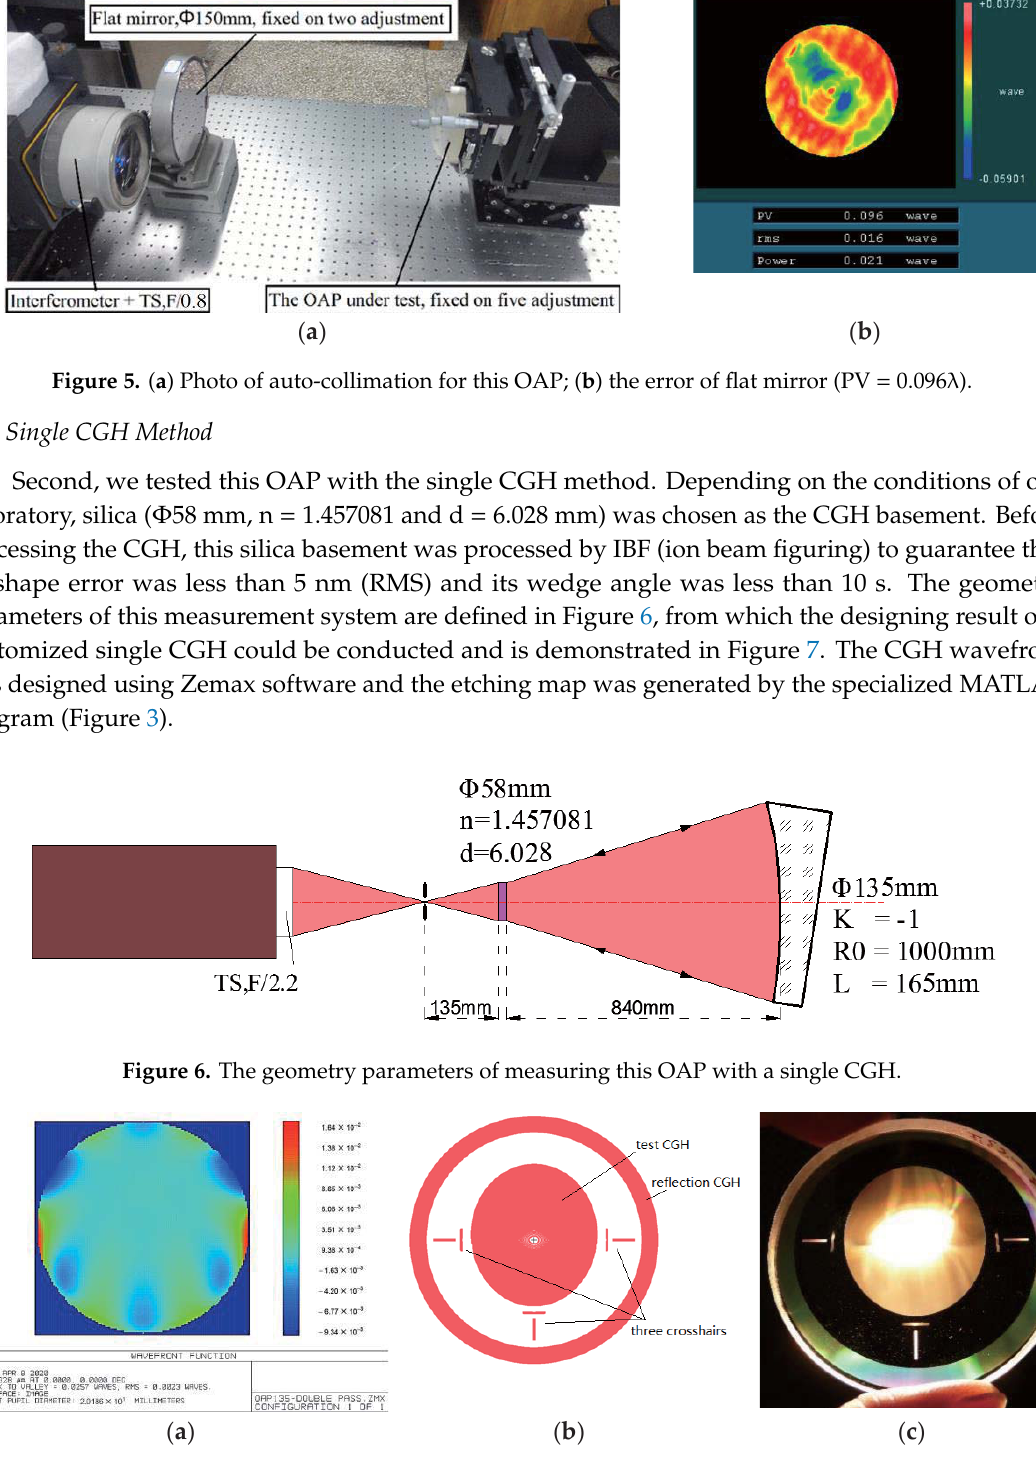
Figure 7. ( a ) Simulated residual wavefront of the single CGH method (test CGH) in Zemax (PV = 0.0257 λ , RMS = 0.0023 λ ); ( b ) simulation pattern of the customized CGH; ( c ) CGH photograph.